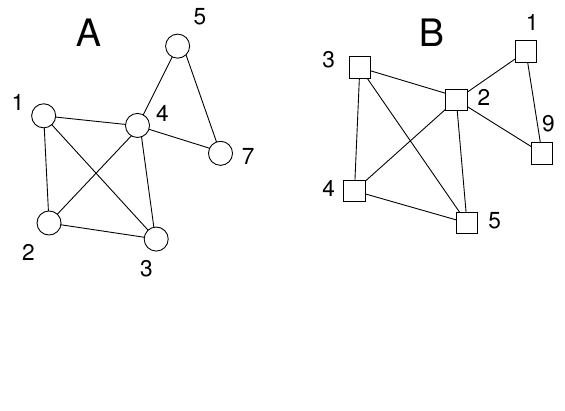
Figure 3. Schematic of situation in Step 3. Two cliques have been identified at the distance tolerance of Step 2, the first given by node pairs a a b b b , a , a . The two cliques have node pair a 4 2 7 9 5 1 into the single graphs shown